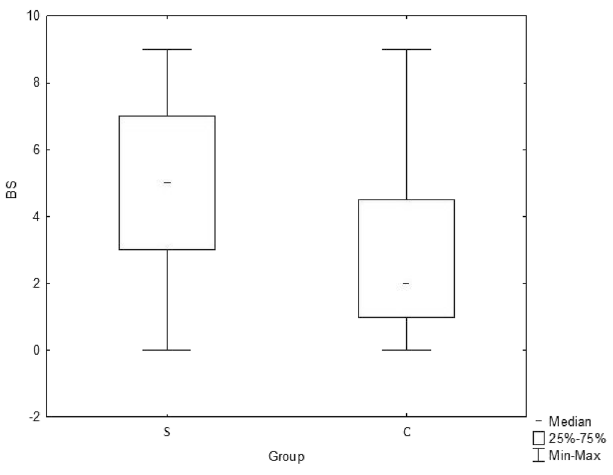
Figure 1. Median Beighton scores (BS) measured in both: study (S) and control (C) group.